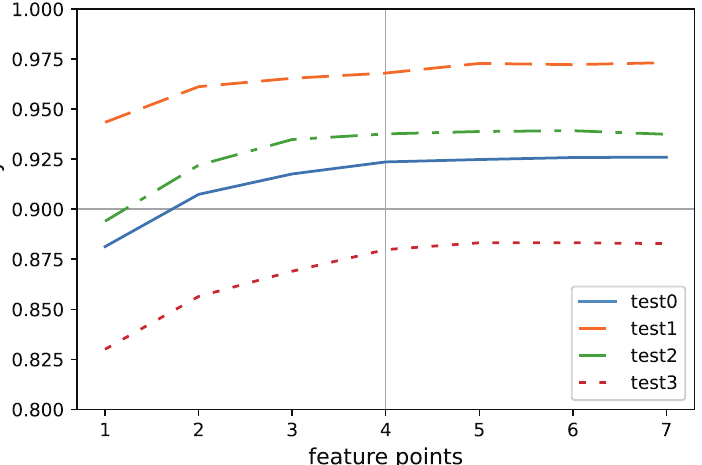
Figure 5. Accuracy as a function of the number of feature points m for datasets test0, test1, test2 and